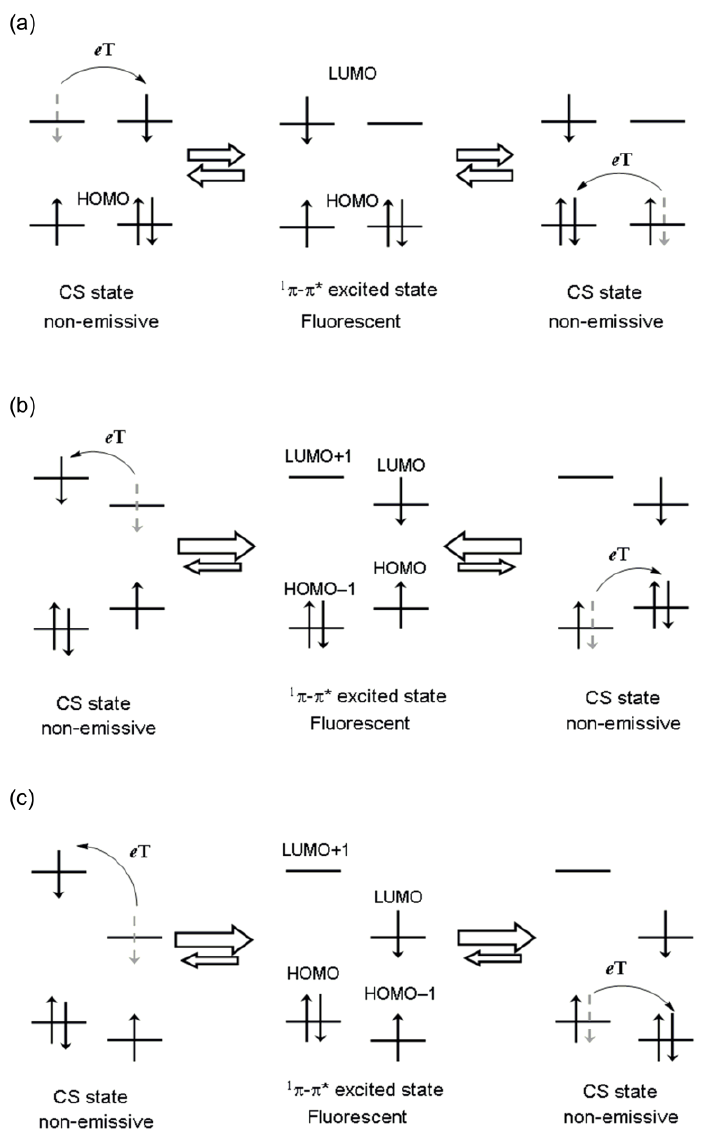
Figure 15. Schematic illustration of charge-separation hypothesis, for ( a ) a homoleptic complex, ( b ) a heteroleptic complex with a favorable frontier orbital order, and ( c ) a heteroleptic complex with an unfavorable frontier orbital order.